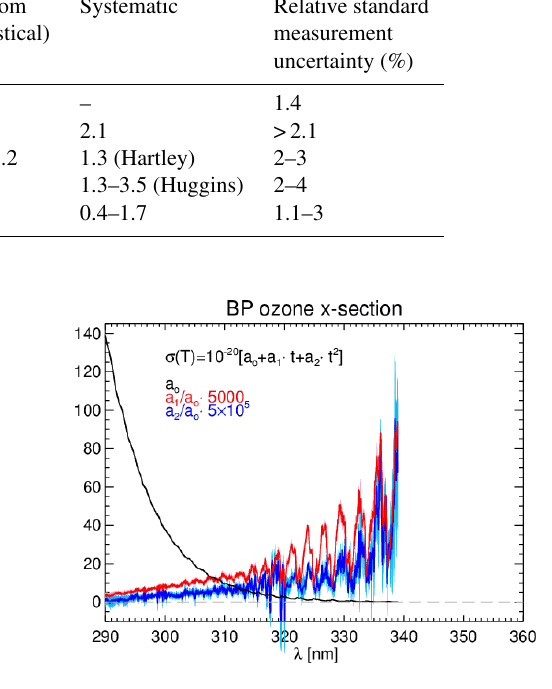
Figure 2. Temperature coefficients and their uncertainty (1 σ ) of the BP data as a function of wavelength λ . For some coefficients and/or selected wavelengths, the uncertainties are too small to be